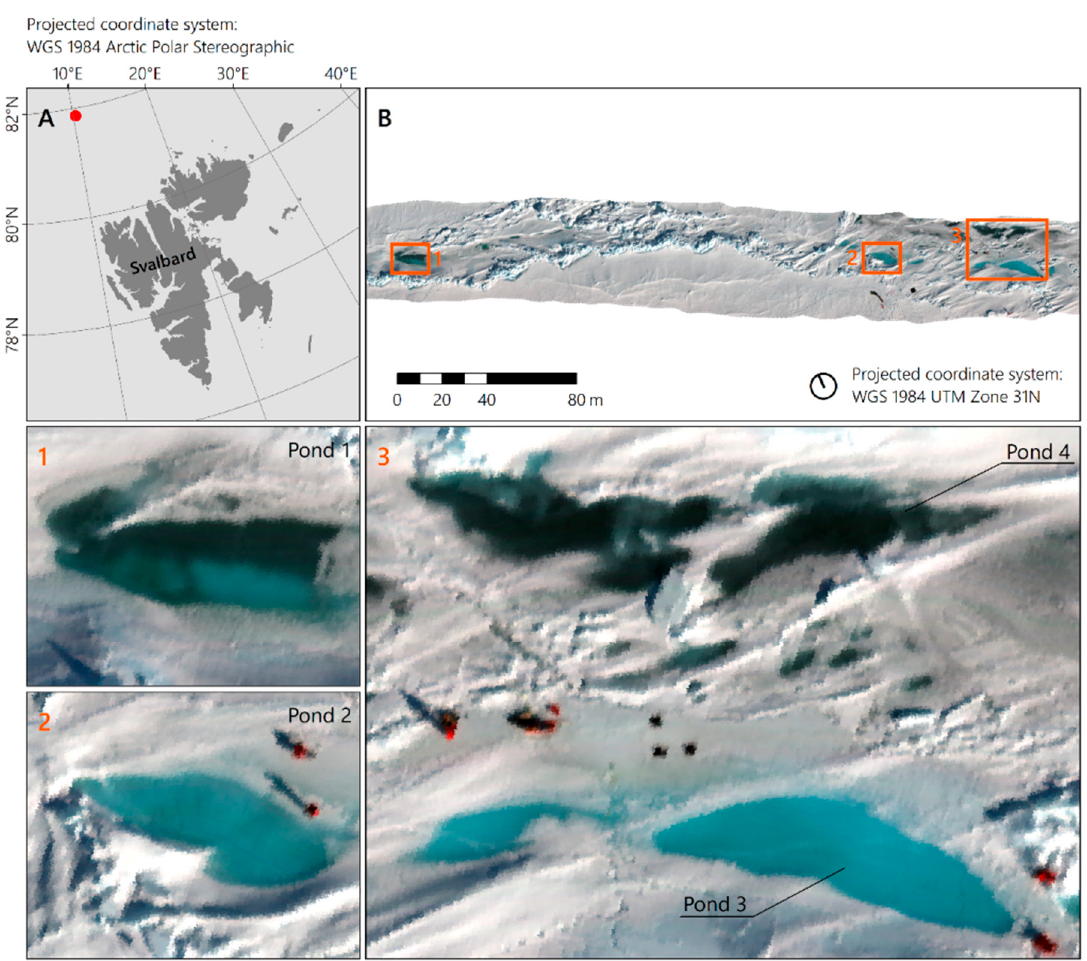
Figure 1. Study area. ( A ) Location in the Arctic Ocean. The red dot indicates the location of ( B ). ( B ) Subset of AisaEAGLE flight stripe containing the surveyed ponds. ( 1 ) Subset of Pond 1. ( 2 ) Subset of Pond2. ( 3 ) Subset of Ponds 3 and 4. Background: AisaEAGLE flight stripe (spatial resolution: 8.5 cm, red, blue and green (RGB): 661.16 nm, 550.25 nm, and 482.57 nm).